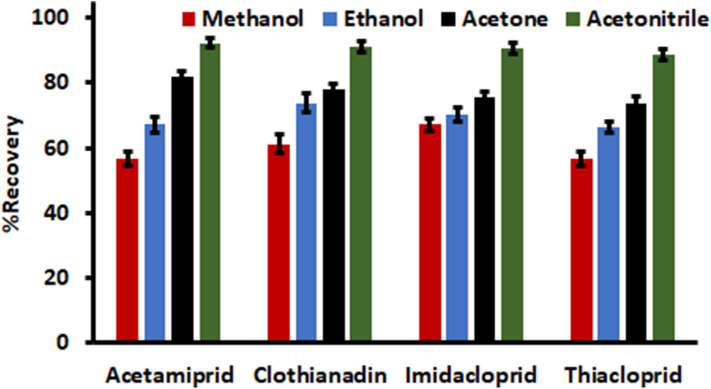
Selection of eluent type. Experimental conditions: sample volume, 5 mL; mass of adsorbent, 15 mg; acetonitrile volume, 750 μL; desorption time, 5 min; extraction time, 15 min and sample pH, 7.0.